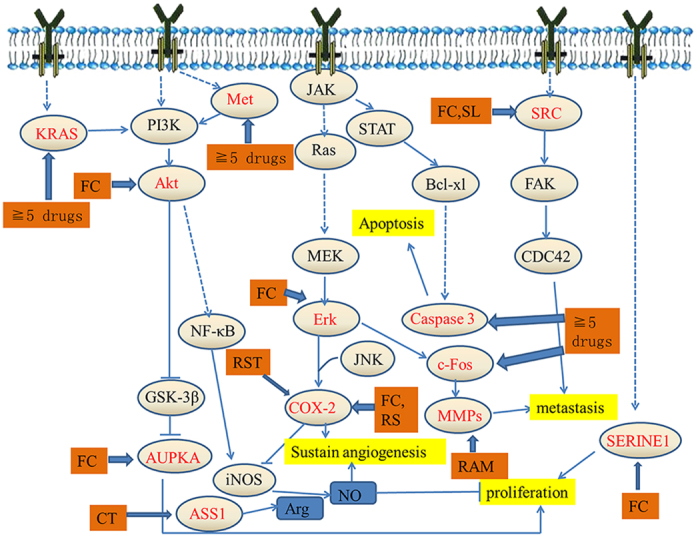
Simplified pathways in HCC.All of the targets are shown by the gene name.